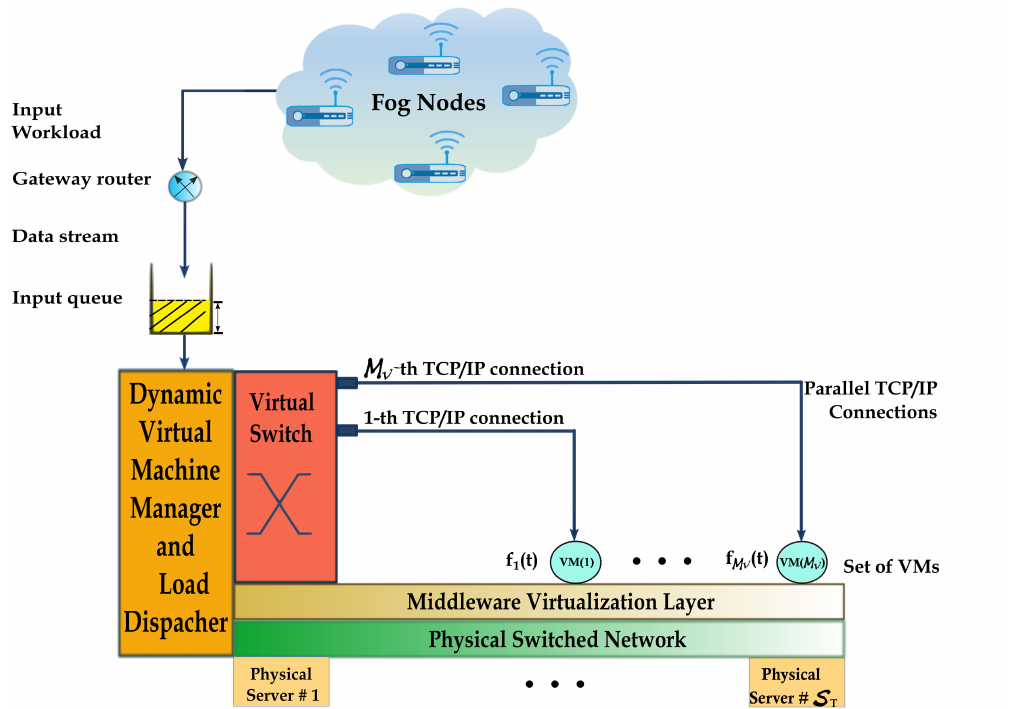
Figure 3. FDC structure in the StreamVehicularFog